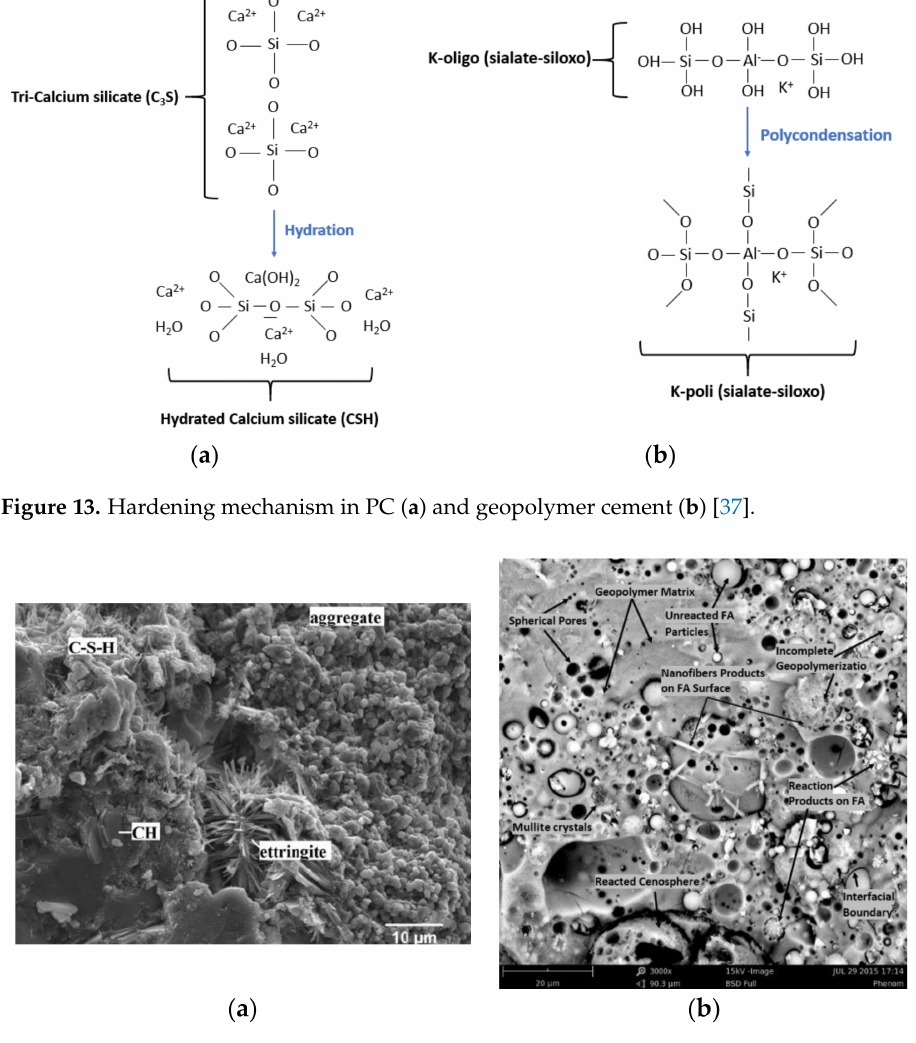
Figure 14. Comparison between ( a ) PC Reprinted with permission from Ref. [70]. Copyright 2013 Microscopy Society of America; and ( b ) FA-based geopolymer cement microstructures. Reprinted with permission from Ref. [71]. Copyright 2016 CRC